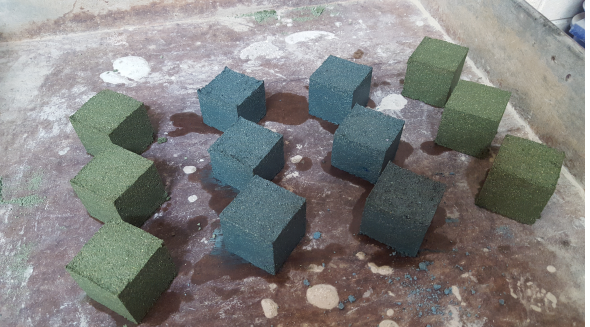
Figure 2: Initial cube mix